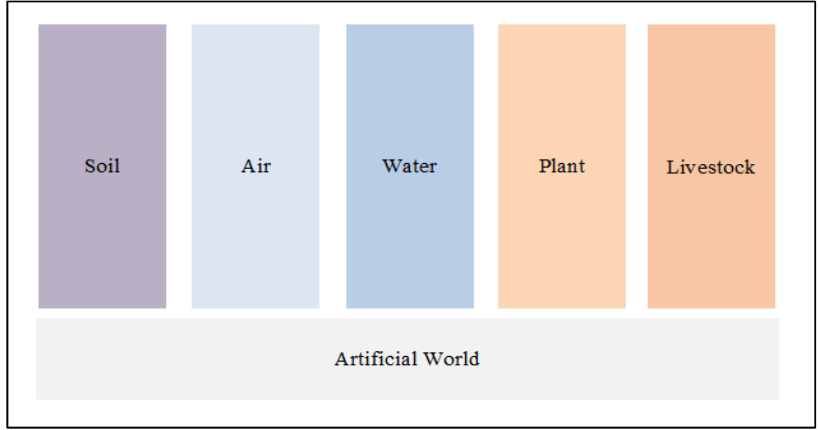
Figure 9. Structure of the Knowledge Base.